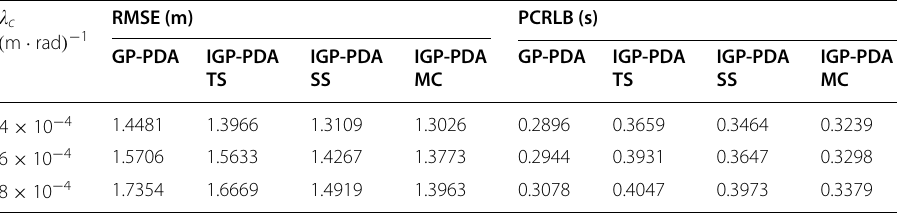
Table 8 Effect of clutter density on contour estimates RMSE and PCRLB in the second